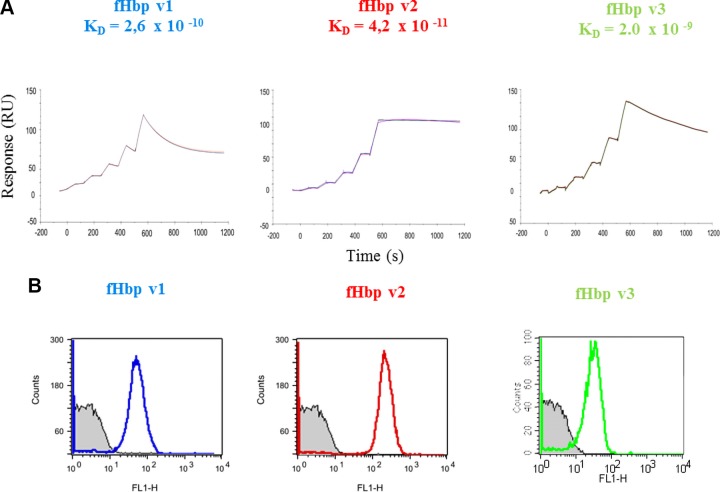
A) Histograms showing binding to live meningococci of MenB strains when incubated with 10 μg/ml of HumAbs anti-fHbp (blue line, MC58 strain; red line UK104 strain; green line, UK320 strain). Gray-filled histogram represents negative control, bacteria incubated with PBS and anti-human IgG fluoresceinisothiocyanate conjugated. B) Sensorgrams show the experimental association and dissociation traces (colored) of binding of mAb 1E6 on 5 incremental concentrations of fHbp v1, v2, and v3, respectively, performed in duplicate. The calculated fitting traces are shown in black.